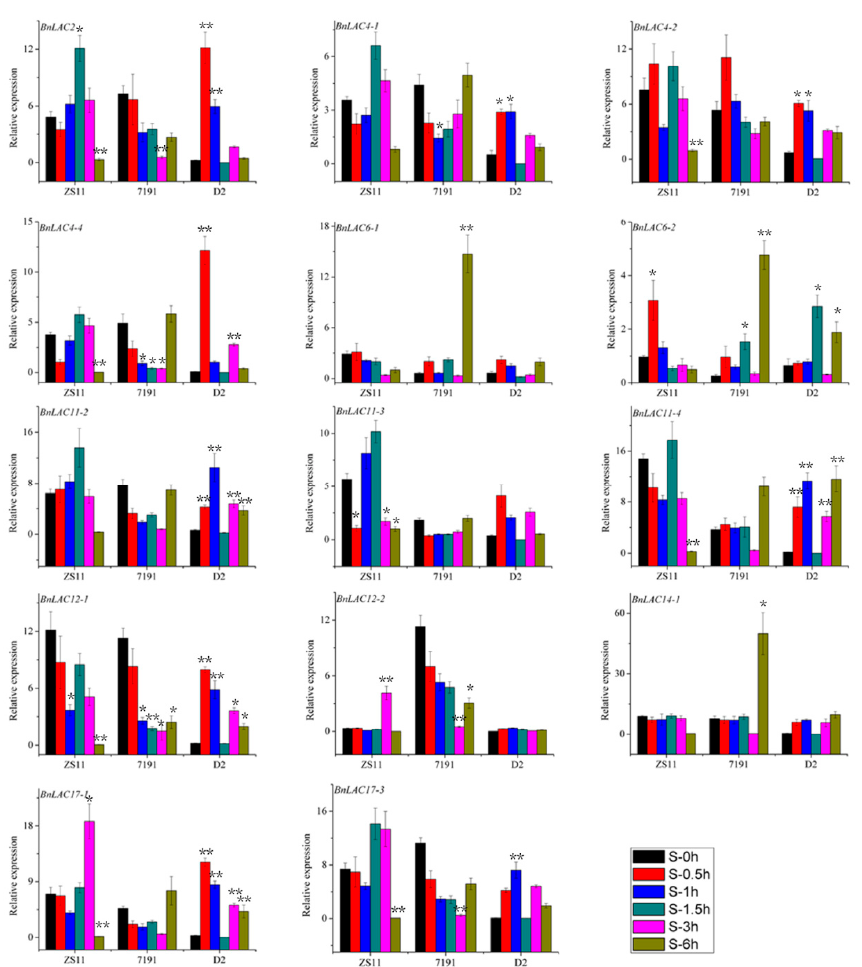
Figure 11. Quantitative RT-PCR of 14 BnLACs in B. napus stems in response to wounding stress. Expression of Actin and UBC21 were used to normalize the expression level of each LAC gene at each time point. Bars represent means ± SEM of three biological replicates. Bars marked with asterisks indicate significant differences (Student’s t-test) to corresponding control samples for the same time point, * P < 0.05, ** P < 0.01. The results were presented by OriginPro 8. Different color means different time after wound shown as bar at lower right corner. 2.7. BnLAC4 and its Predicted Downstream Genes are Differentially Expressed in the Silique Pericarp between Long and Short Silique Lines In STRING platform, CTL2, IRX3, CESA4, IRX1, LAC17, GAUT12, IRX6, PGSIP1, GLP10 and